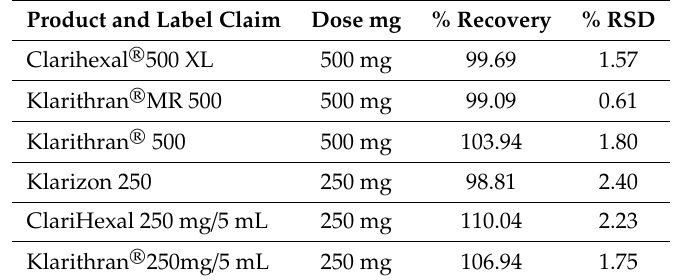
Table 10. Analysis of commercially available CLA formulations ( n =